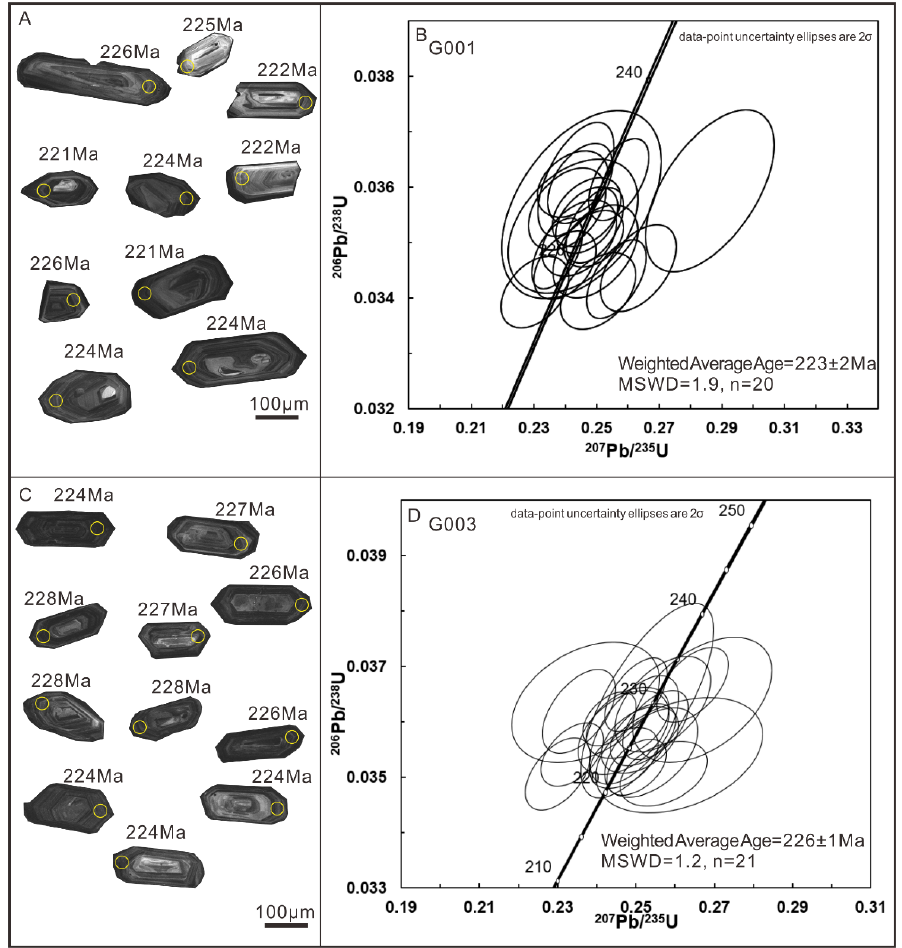
Figure 5. Typical CL images ( A , C ) and LA-ICP-MS zircon U-Pb concordant curves ( B , D ) of zircon of Baishi granite. The yellow, solid-line circles represent the locations of zircon U-Pb. 6.3. LA-ICP-MS Monazite U-Pb Dating and Rare Earth Elements Analysis